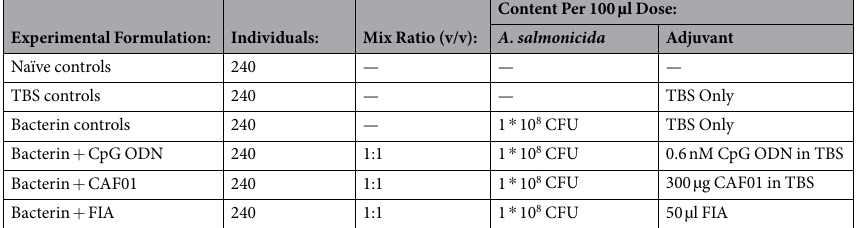
Table 1. Treatment specifications for each experimental group. The naïve controls did not receive any